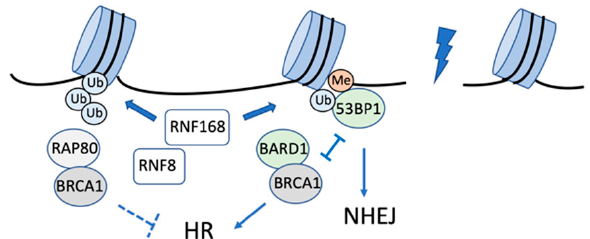
Figure 2. Model of H2AK13/15 ubiquitination and reader proteins in the DNA damage response. RNF168-induced H2AK13/15 ubiquitination leads to the activation of the NHEJ (53BP1) or HR (BRCA1/BARD1) pathway. RNF8-RNF168 induced K63-linked chains to recruit the BRCA1-A complex (RAP80/BRCA1) and restrict the HR pathway.